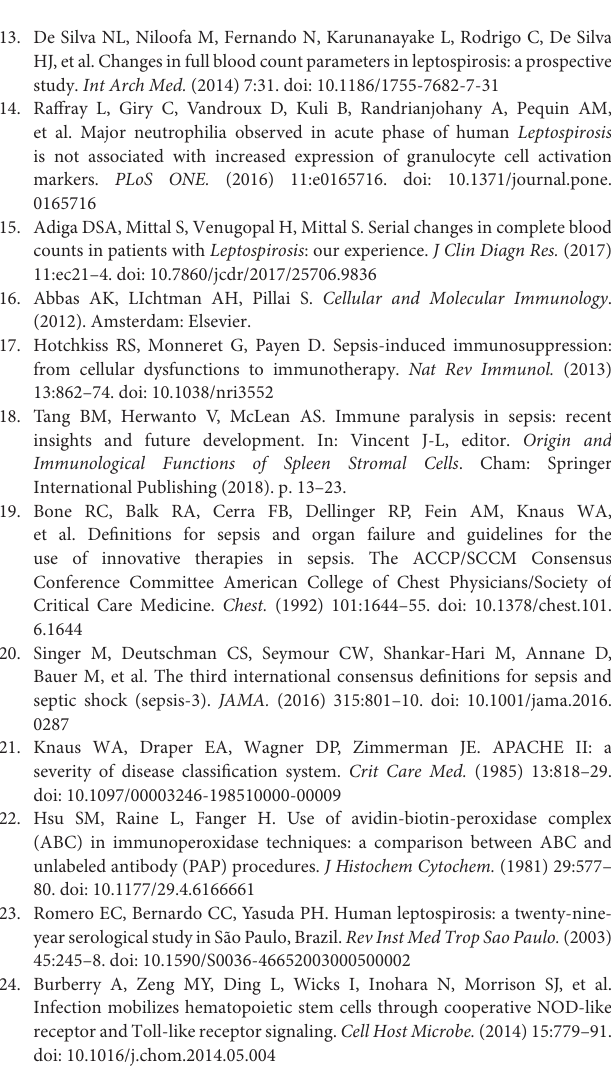
Supplementary Figure 1 | Positive immunohistochemical controls for low-expressing cytokines. Expression of the following cytokines was found to be very low in all groups (leptospirosis, sepsis and control). This figure shows positive staining in control spleen: (a) IL-1 β ; (b) IFN- γ ; (c) IL-2; (d) IL-6. Magnification: 400 × (a,c) ; 200 × (b,d)